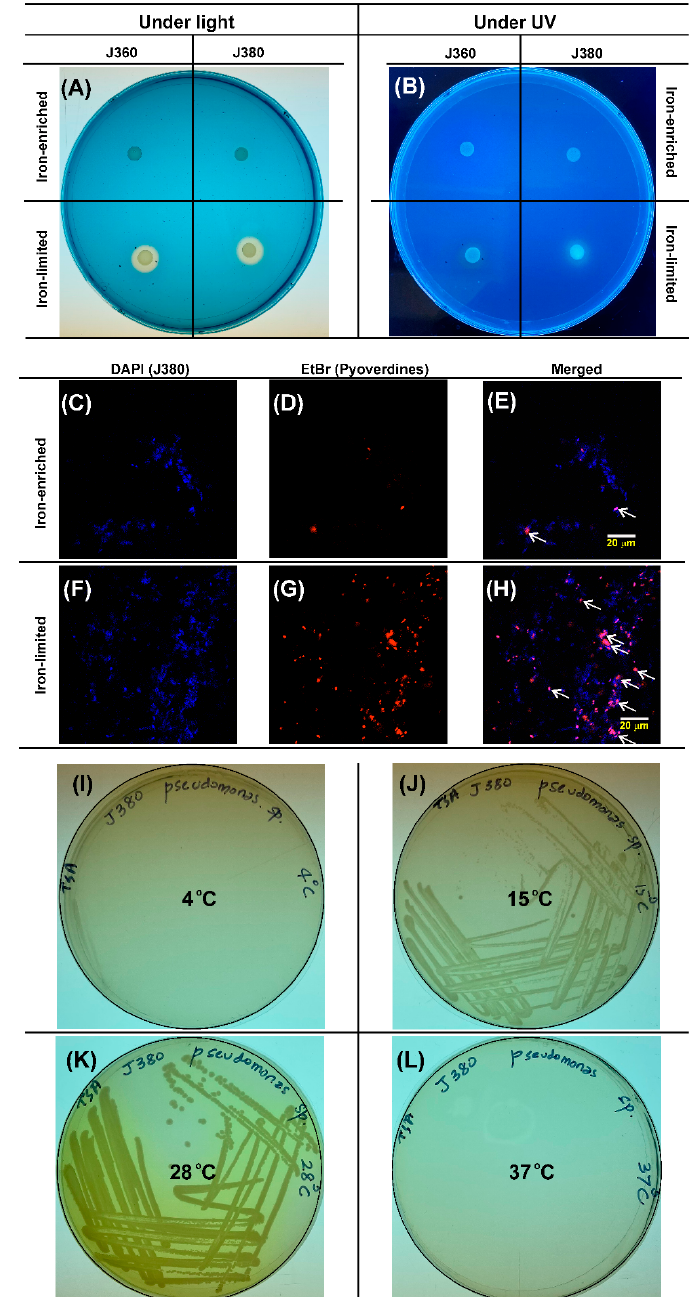
Figure 1. Pseudomonas sp. strain J380 produces fluorescent-active iron-binding siderophores (pyoverdine) under iron-limited growth conditions. V. anguillarum J360 represents the control. Bacteria were grown at 15 ◦ C in trypticase soy broth (TSB) supplemented either with 100 µ M FeCl 3 or 100 µ M 2,2’-dipyridyl (DIP) to provide iron-enriched and iron-limited conditions, respectively. ( A , B ) Blue agar CAS plate assay for two bacterial strains grown under iron-enriched and –limited conditions visualized under ( A ) normal light and ( B ) UV. Pale yellow halos around spotted cultures indicate siderophore synthesis and fluorescent halo under UV indicates pyoverdine production. ( C – H ) Confocal microscopic visualization of Pseudomonas sp. J380 labeled with DAPI. Pyoverdine secretion was evident under the EtBr filter and indicated by white arrows in merged pictograms. J380, Pseudomonas sp. strain J380; J360, V. anguillarum J360; EtBr, ethidium bromide. ( I – L ) Analysis of Pseudomonas sp. J380 growth under different temperatures. Pseudomonas sp. J380 was incubated onto TSA under four different temperatures for 24 h. ( I ) 4 ◦ C (slight growth was observed), ( J ) 15 ◦ C, ( K ) 28 ◦ C (synthesis of pyoverdine was observed; yellow/fluorescent colonies), and ( L ) 37 ◦ C (even after 7 days of incubation, no bacterial colonies were